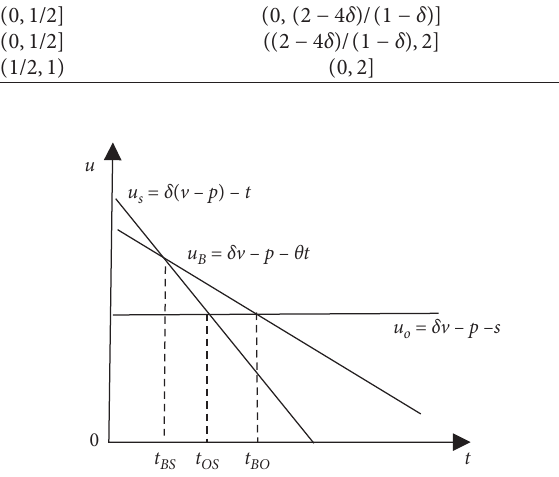
Figure 3: Consumers’ utility function when offered